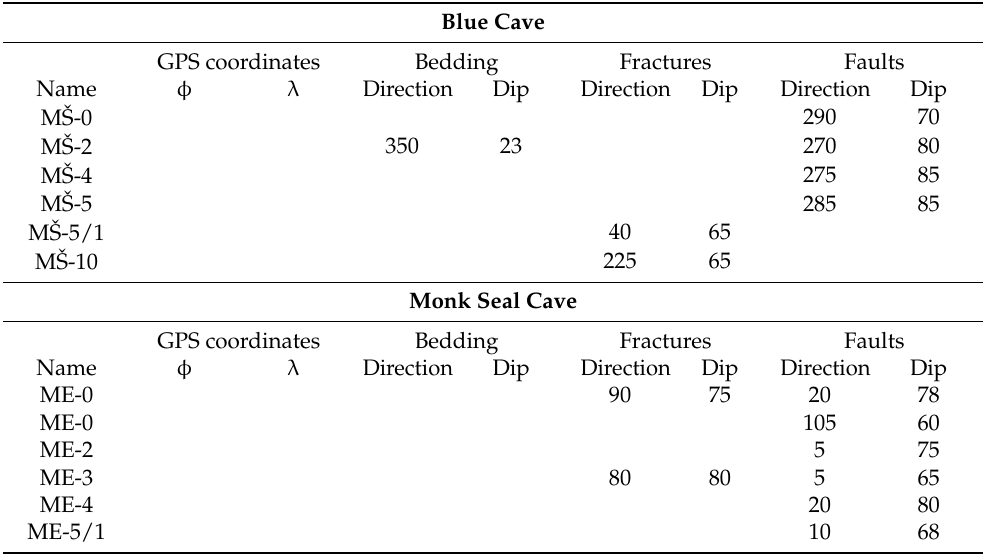
Table 3. Tectonic and depositional discontinuities measured inside of the Blue Cave and Monk Seal Cave. Blue Cave GPS coordinates Bedding Fractures Faults Name φ λ Direction Dip Direction Dip Direction Dip MŠ-0 290 350